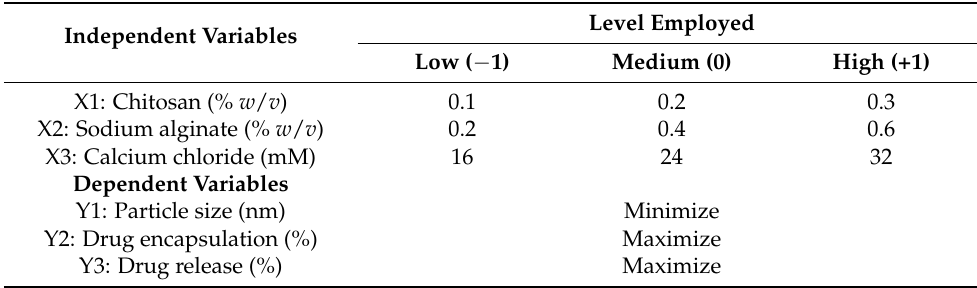
Table 1. The independent variables and levels employed as low (0), medium ( − 1), and high (+1) in statistical optimization of β